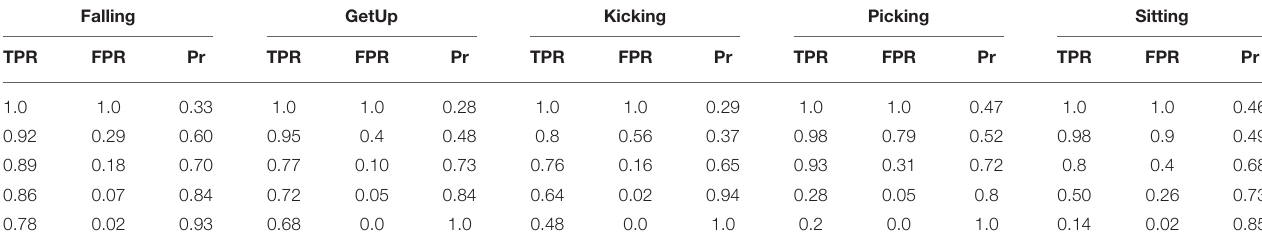
TABLE 4 | Quantitative analysis of proposed network in terms of True-Positive Rates (TPR), False-Positive Rates (FPR), and Pr (Precision). Falling GetUp Kicking Picking